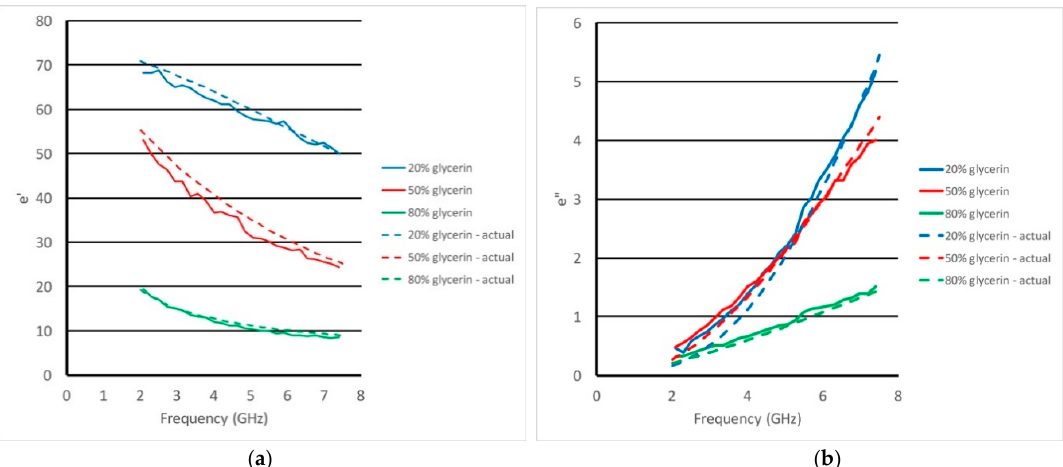
Figure 5. Plots of the recovered ( a ) real and ( b ) imaginary permittivity values using the transmission probe technique compared to the actual property values as a function of frequency for a range of glycerin:water mixtures: 80:20, 50:50 and 20:80,